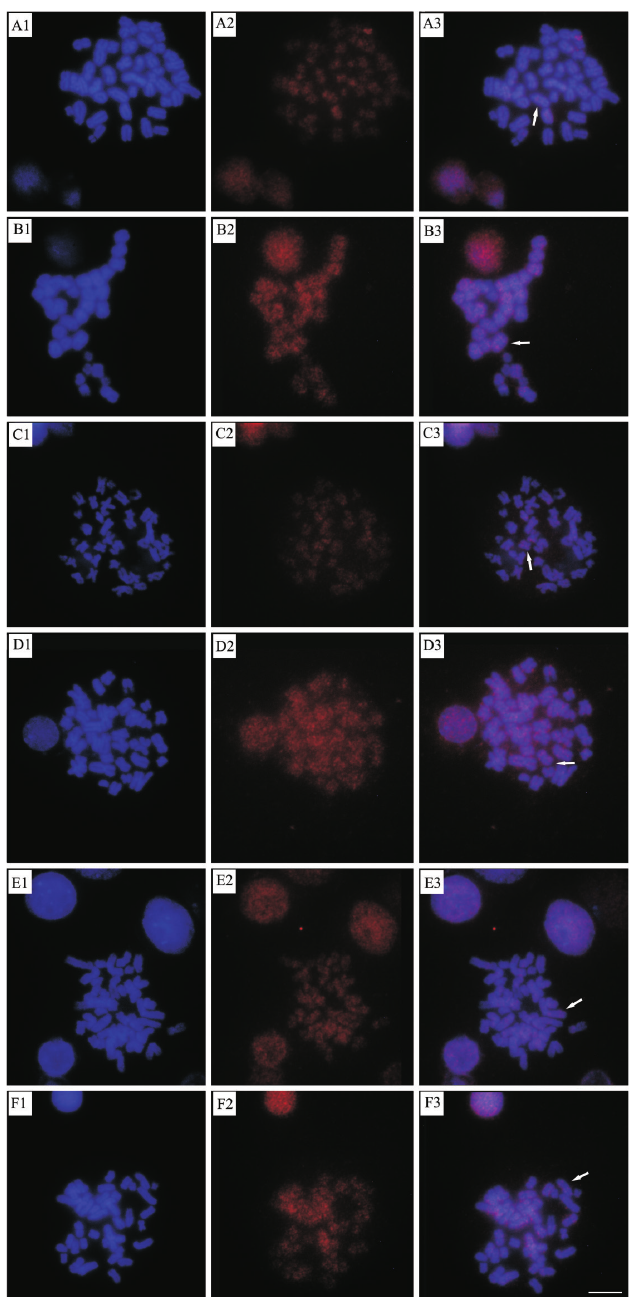
Figure 5. In situ fluorescence hybridization using AnDraI as probe in Ancistrus chromosomes: A Female of Currupira creek B Male of Currupira creek C Female of Pari creek D Male of Pari creek E Female of Sangradouro creek e F Male of Sangradouro creek. The arrows show some examples of pericentromeric and spread signals. Bar = 10